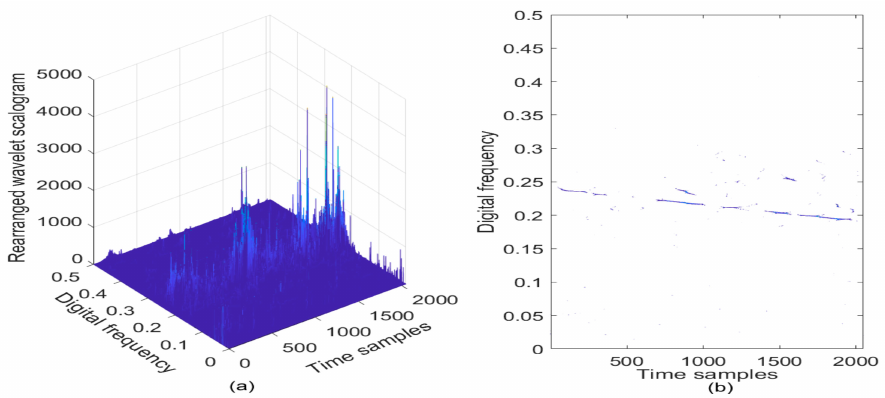
Figure 10. Rearranged wavelet scalogram of the GPS L1-C/A signal in the presence of sweep interference. C / N 0 = 40 dB-Hz, JNR = − 2 dB. ( a ) Rearranged wavelet scalogram; ( b ) Contour of rearranged wavelet